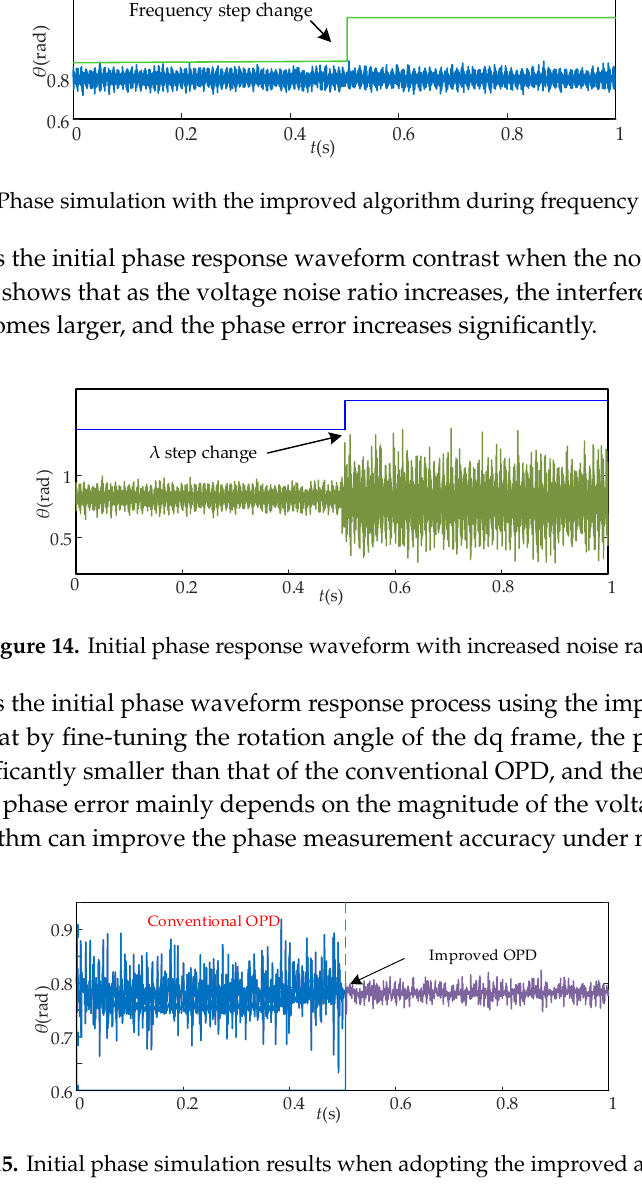
Figure 13. Phase simulation with the improved algorithm during frequency step change.